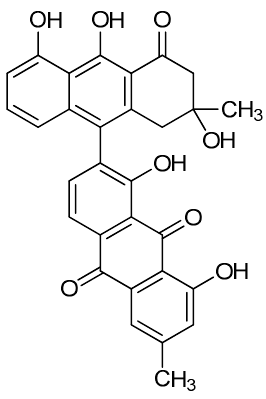
Figure 4. Chemical structure of T510.